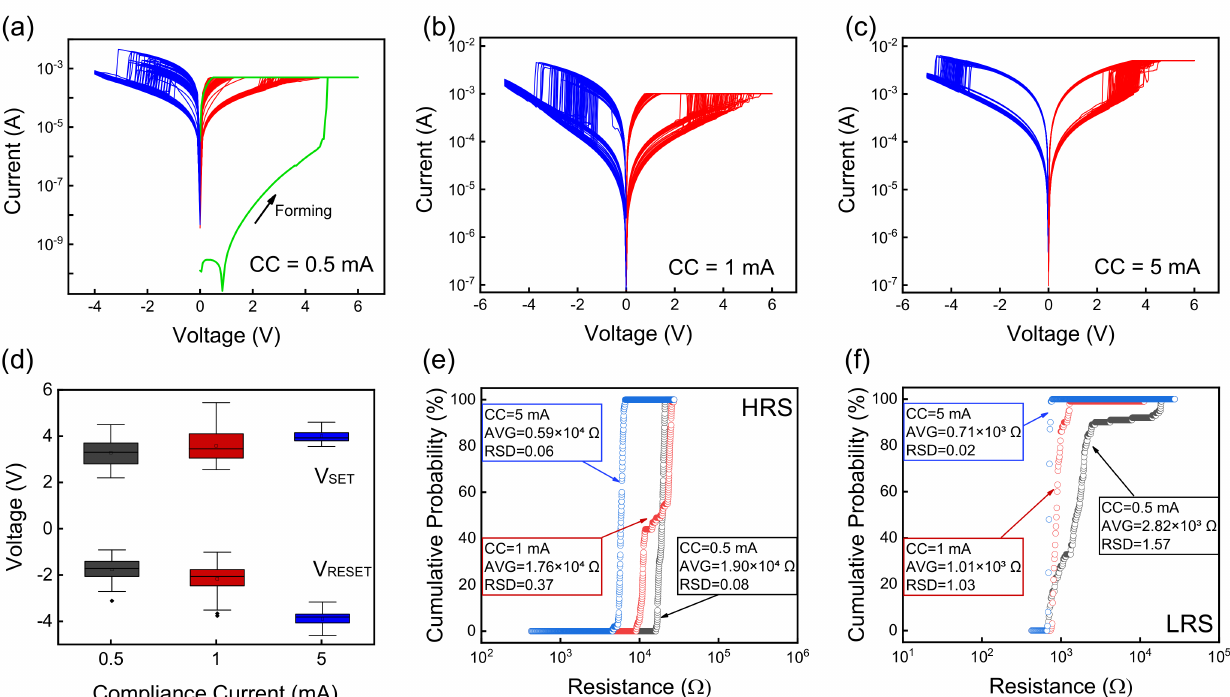
Figure 3. ( a ) I-V curves of CC = 0.5 mA, ( b ) CC = 1 mA and ( c ) CC = 5 mA. ( d ) Box chart of set voltages and reset voltages of each CCs. Cumulative probability of resistance of ( e ) HRS and ( f )